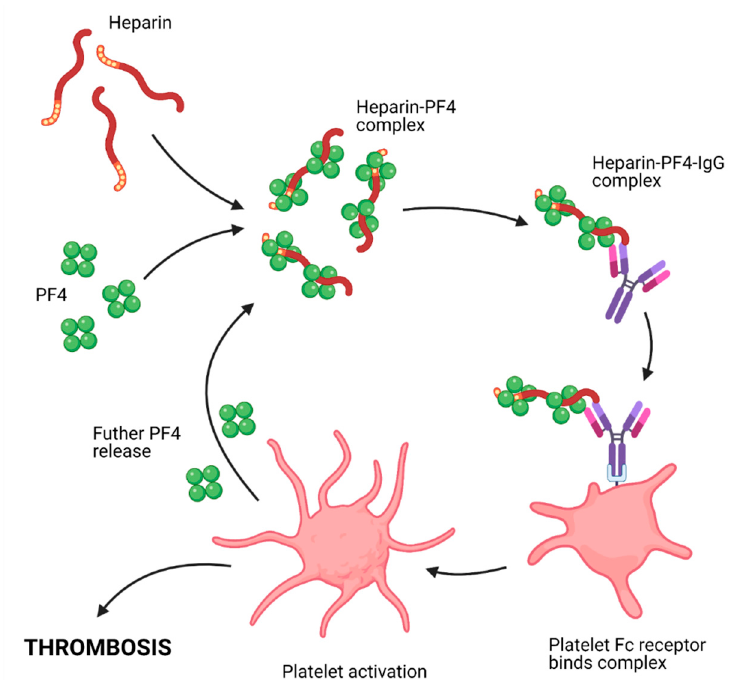
Figure 1. Diagrammatic representation of the mechanism by which HIT can cause thrombosis. (HIT: heparin induced thrombocytopenia.)